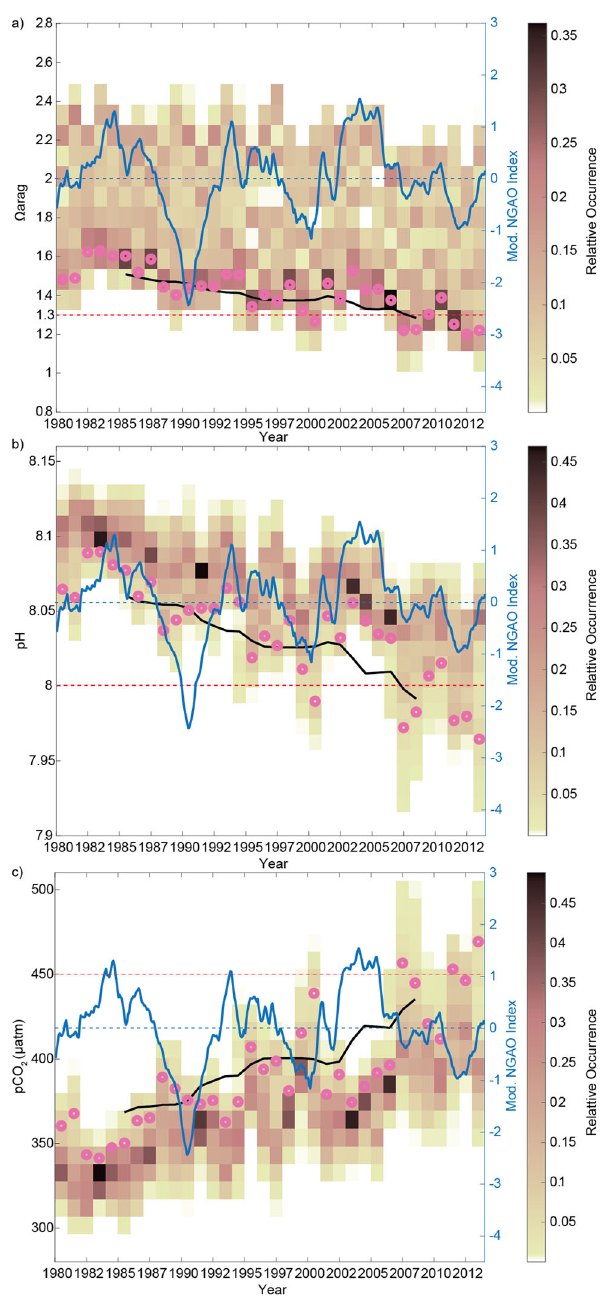
Fig. 3 Occurrences of ocean acidi fi cation extreme events. Plots showing the relative occurrence of a saturation state for aragonite ( Ω arag ), b pH, and c pCO 2 ( μ atm) for an area in the middle of the subpolar gyre (55 °N to 57 °N, 147 °W to 150 °W) from 1980 through 2013. The blue line shows the Northern Gulf of Alaska Oscillation (NGAO) index at a monthly frequency, smoothed with a 12 month running mean to highlight the effect of sub-decadal pulse disturbances on top of the decadal press from rising atmospheric CO 2 . The dashed blue line separates the positive from the negative NGAO phases. The solid black line shows the 10th percentile of the distribution of Ω arag and pH, and the 90th percentile of the distribution of pCO 2 after applying a 10-year low pass fi lter to illustrate when an arbitrary threshold would be crossed as a result of the long-term press of ocean acidi fi cation. The pink dots show the 10th percentile of monthly Ω arag and pH, and the 90th percentile of monthly pCO 2 model output to indicate when an arbitrary threshold would be crossed as a consequence of the NGAO (or pulses) in addition to seasonal periods of ocean acidi fi cation stress. The dashed red line is an arbitrary threshold to mark extreme events, when the sub-decadal pulse disturbances push the system across these thresholds ( Ω arag = 1.3; pH = 8.0; pCO 2 = 450 μ